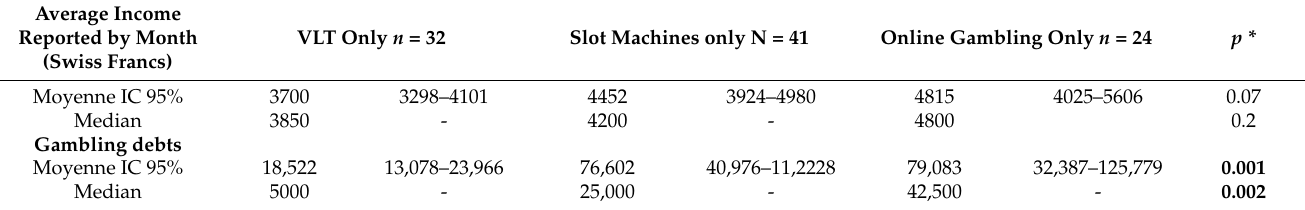
Table 2. Debts and income according to player-type.